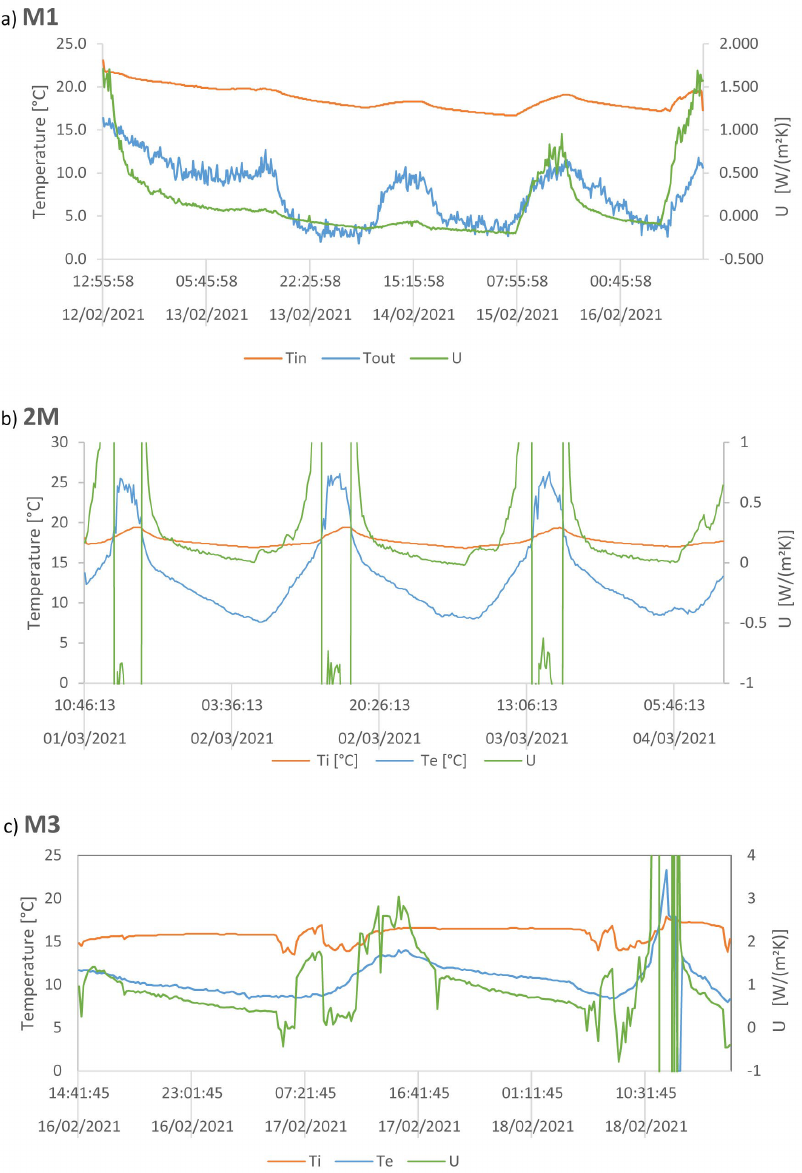
Figure 3. Temperature and heat flux measurements of the investigated façades: M1 ( a ), M2 ( b ), M3 ( c ).